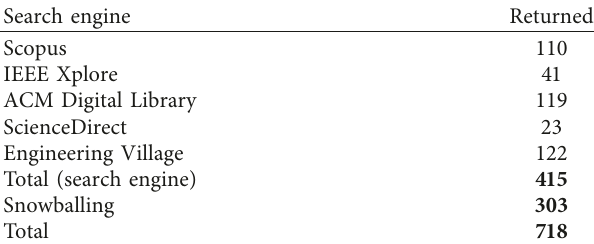
Table 2: Papers returned in the initial search. Search